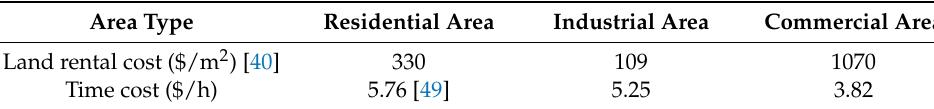
Table 4. Land rental cost and time cost of users in different areas.